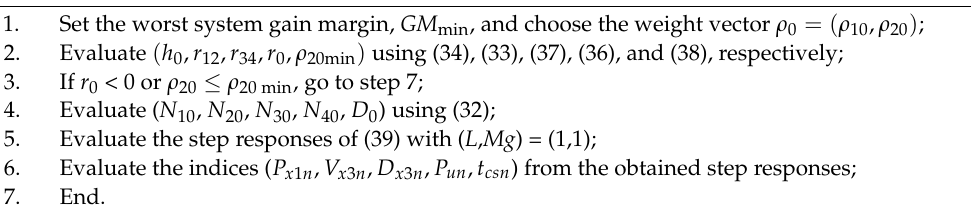
Algorithm 1: Controller design and closed-loop linearized CIP system